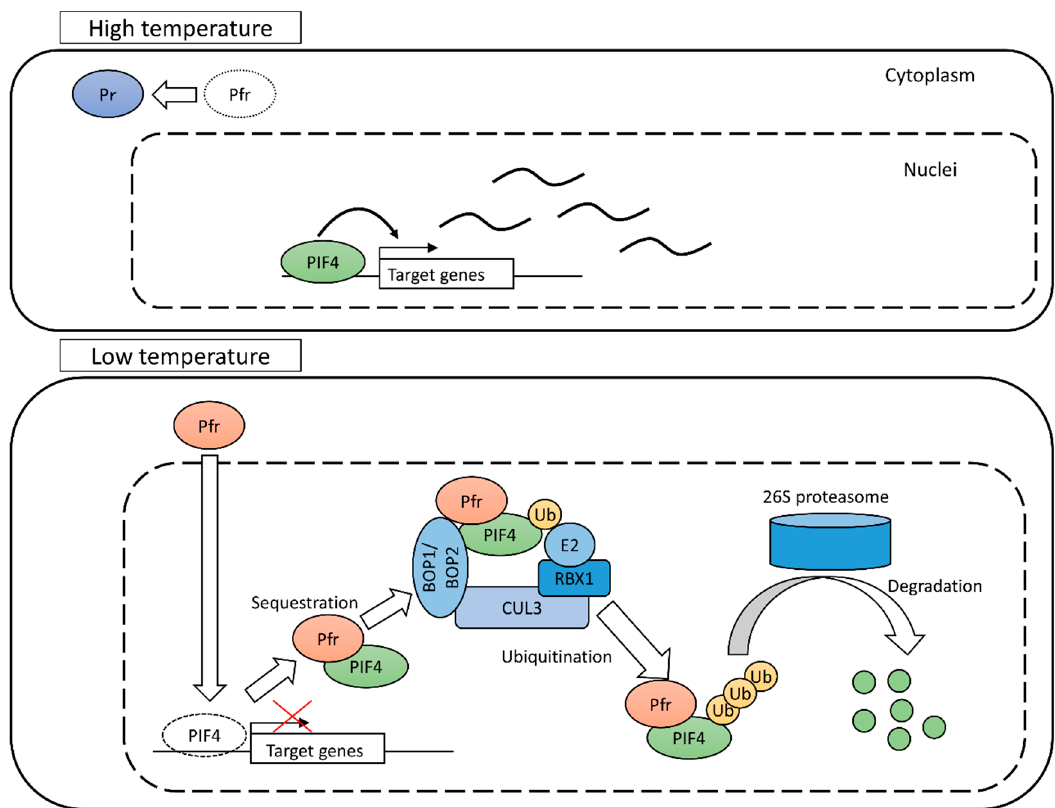
Figure 2. The mechanism of the temperature sensing system based on phyB and PIF4. At high temperature, phyB gets converted to the inactive Pr state and is located in the cytoplasm. The PIF4 binds to the regulatory region of target genes and regulates their expression. At low temperature, phyB is in an active state and enters the cell nucleus. The PIF4 is sequestrated from target genes by binding to phyB. The PIF4 is degraded by 26 proteasomes through ubiquitination. The activity of PIF4 is suppressed at low temperature.